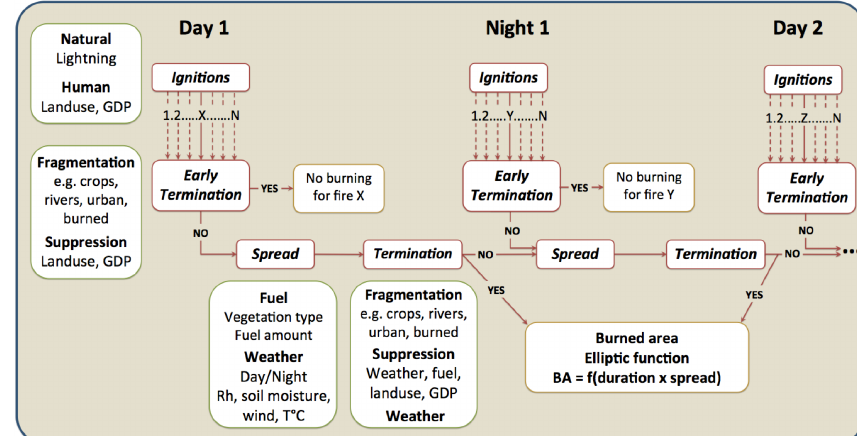
Figure 1. HESFIRE